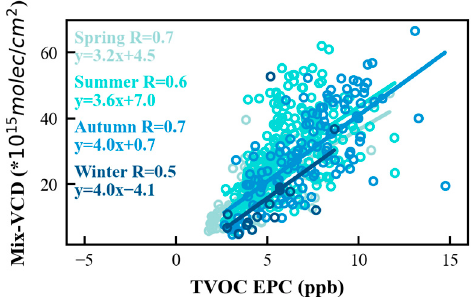
Figure 4. Correlations of Mix and TVOC EPC.